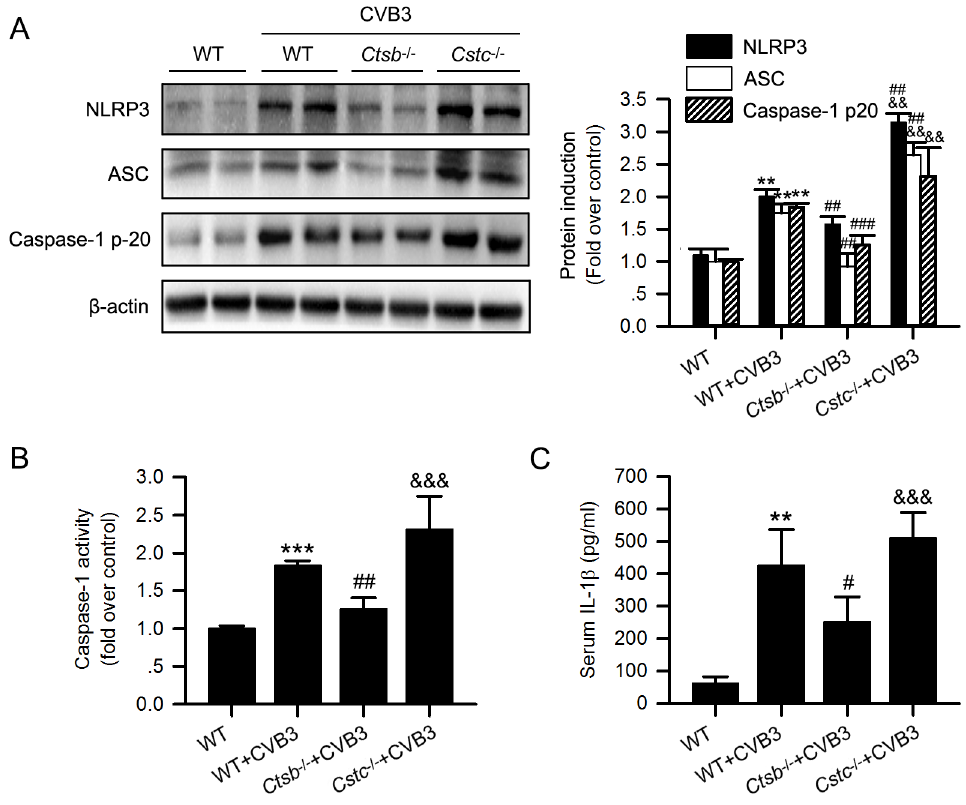
Fig 5. CatB deficiency reduced while cystatin C deficiency increased the activation of the NLRP3 inflammasome induced by CVB3 infection. (A) Western blot analysis of the expression of the components of the inflammasome including NLRP3, ASC, caspase-1 p-20 in hearts from mice receiving different treatments. (B) Cardiac caspase-1 activity was determined by a commercial assay kit and presented as fold change compared with the WT mice receiving DMEM. (C) Compared with WT+CVB3 group, CatB deficiency significantly decreased the serum IL-1 β level while cystatin C deletion increased the level of IL-1 β . (WT group: n = 10; WT+CVB3 group: n = 14; Ctsb -/- +CVB3 group: n = 12; Cstc -/- +CVB3 group: n = 11; (cid:3)(cid:3) P < 0.01 vs . WT group; (cid:3)(cid:3)(cid:3) P < 0.001 vs . WT group; #P < 0.05 vs . WT+CVB3 group; ##P < 0.01 vs . WT+CVB3 group; ###P < 0.001 vs . WT+CVB3 group; &&P < 0.01 vs . Ctsb -/- +CVB3 group; &&&P < 0.001 vs . Ctsb -/- +CVB3